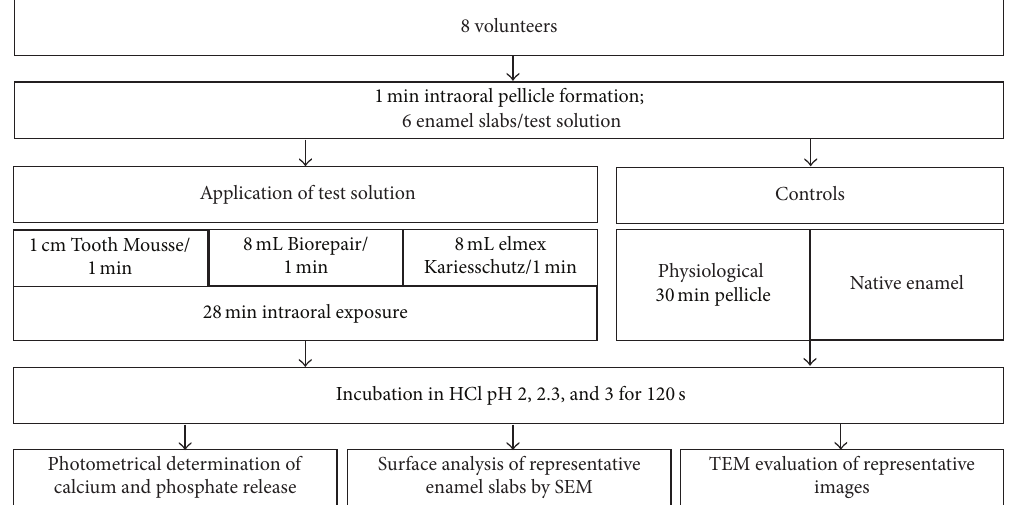
Figure 1: Flowchart of the